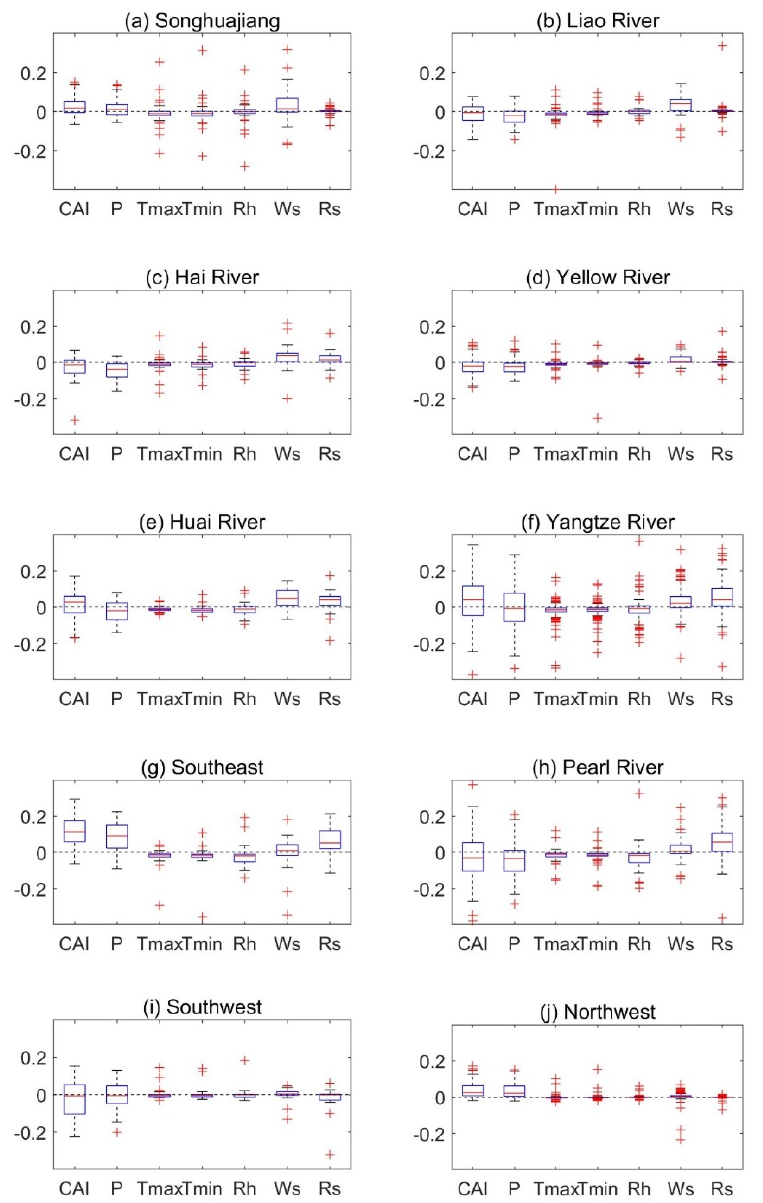
Figure 7. Attribution of changes in the aridity index (CAI) from 1961–1988 to 1989–2016 in the ten basins. The climatic variables are denoted by P (precipitation), Tmax (maximum temperature), Tmin (minimum temperature), Rh (relative humidity), Ws (wind speed), and Rs (radiation) on the x axis. The vertical spread of the box-whisker plots shows the variations in results among climate stations within each basin. The boxes cover the ranges from the 25% quartile to the 75% quartile of the distributions, with the median values marked by red lines within each box and outliers marked by plus signs.